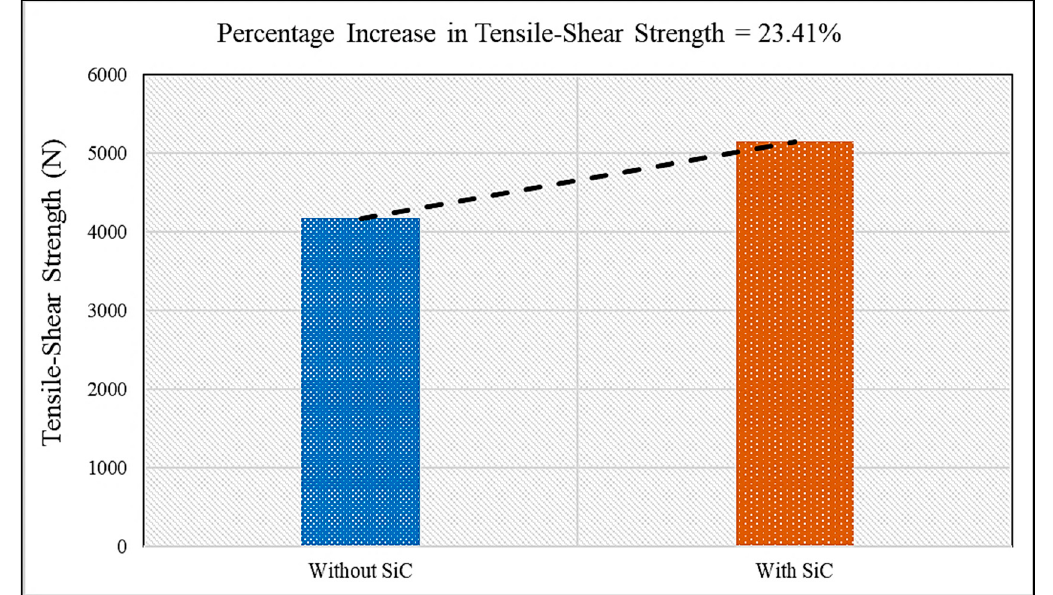
Figure 13. Comparative analysis of the tensile–shear load of FSS Welds without SiC and with SiC.